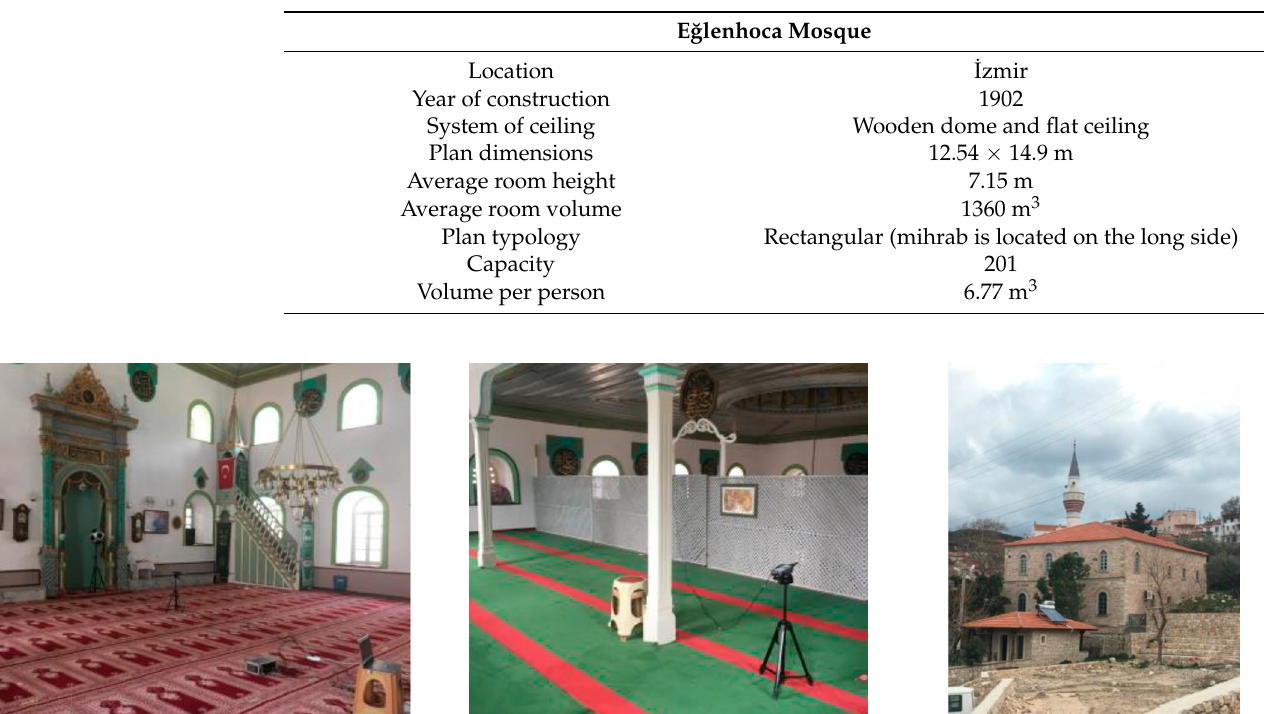
Table 5. The architectural features of E˘glenhoca Mosque.